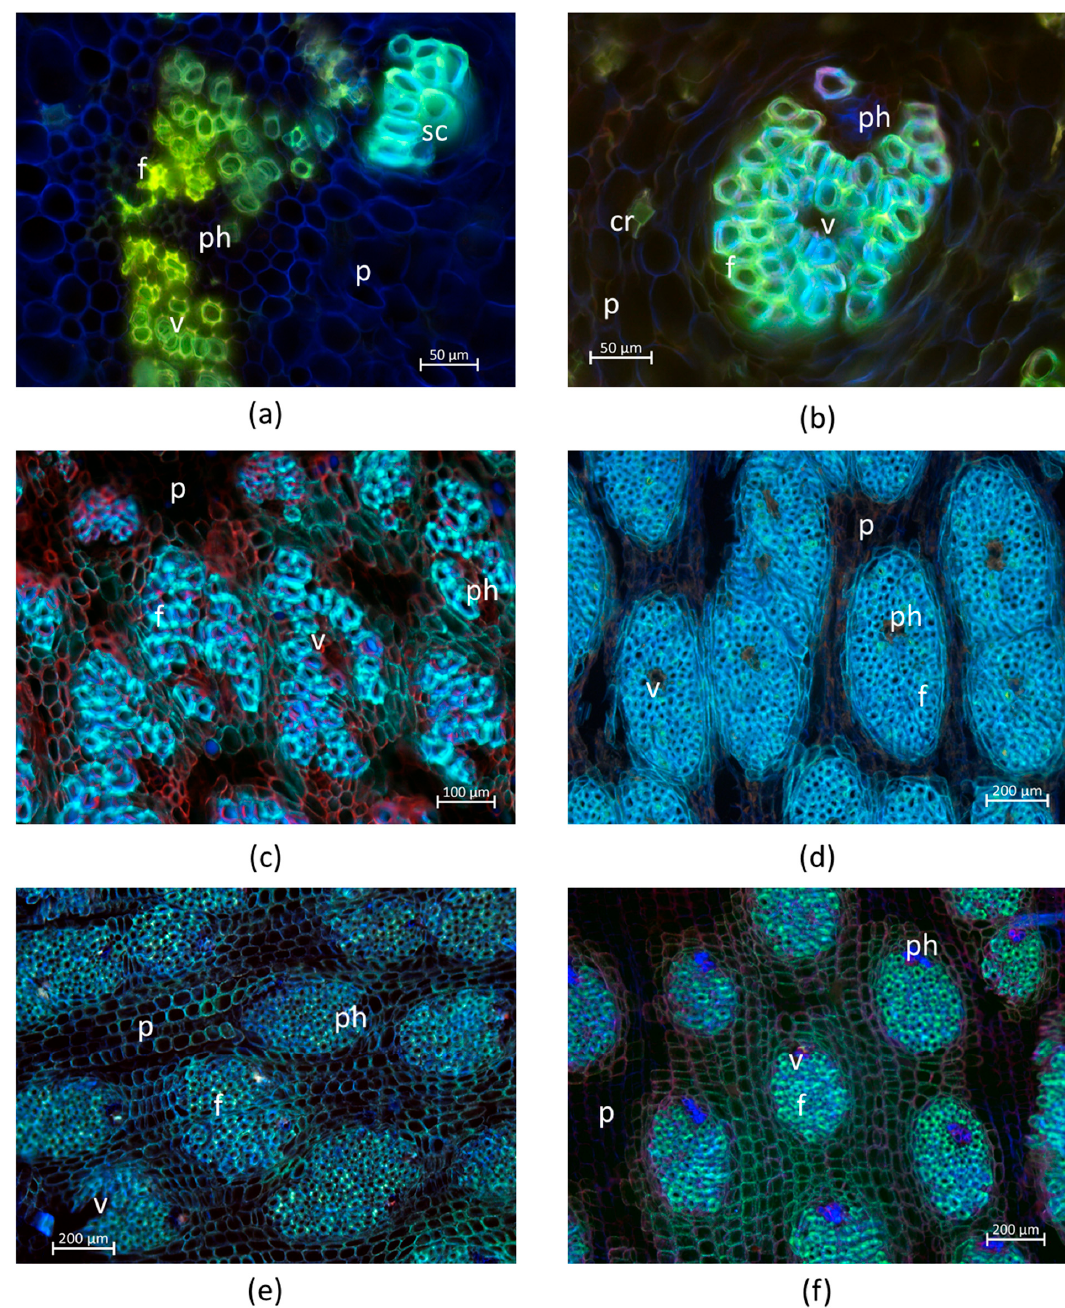
Figure 4. Fluorescence images from representative Asparagaceae species. ( a ) A. attenuata. ( b ) A. convallis . ( c ) B. gracilis . ( d ) N. excelsa . ( e ) Y. gigantea . ( f ) Y. periculosa . f: fiber, v: vessel, p: parenchyma, ph: phloem, cr: crystal.